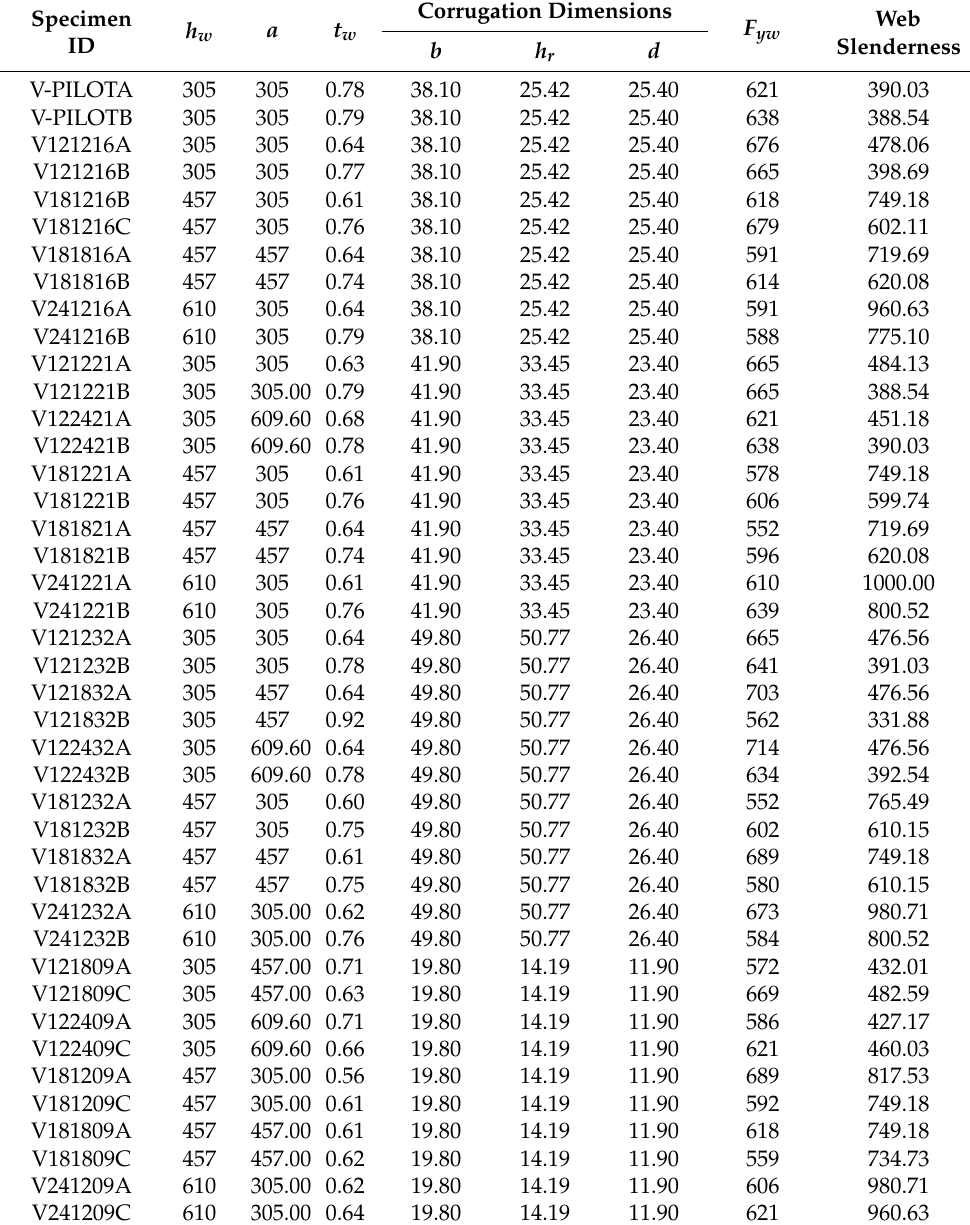
Table A2. Data of specimens tested by Elgaaly et al. [2].